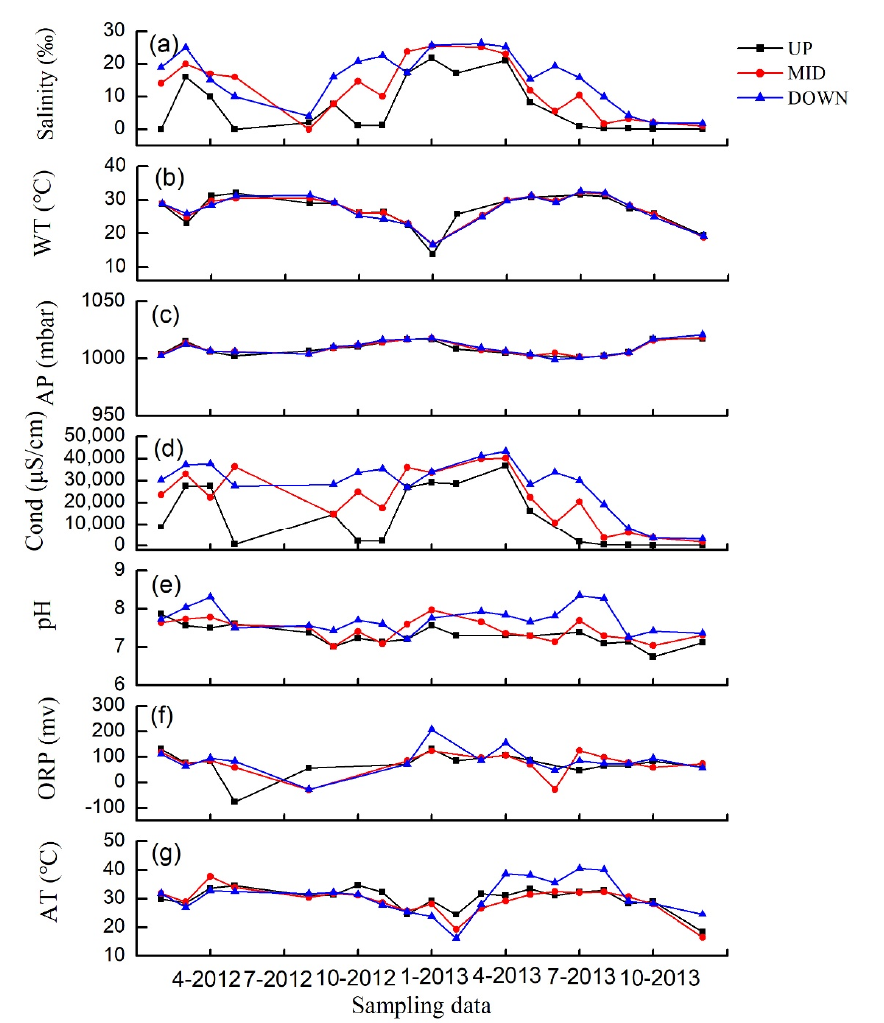
Figure 3. Variations of water variables during sampling months. ( a ) Salinity; ( b )WT: water temper- ature; ( c ) AP: Atmospheric pressure; ( d ) Cond: Conductivity; ( e ) pH; ( f ) ORP: Oxidation-Reduction Potential; ( g ) AT: air